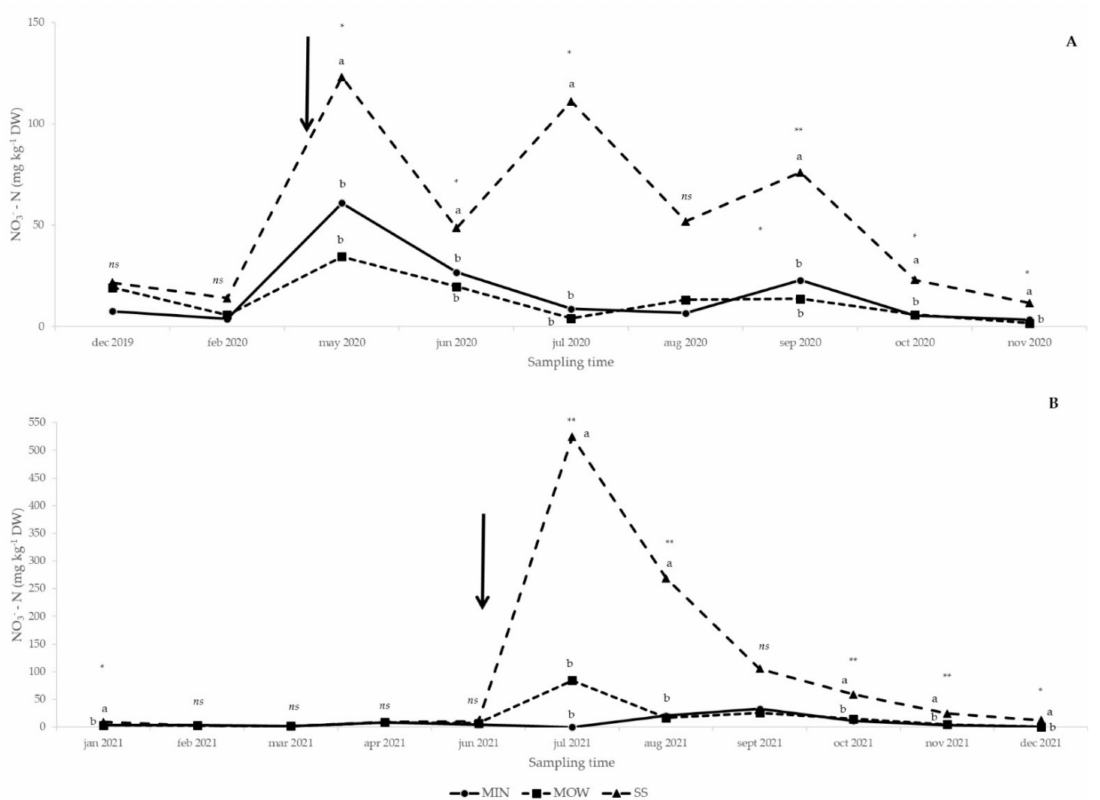
Figure 1. Effect of fertilization treatments on soil nitrate-N (NO 3 − -N) concentration from